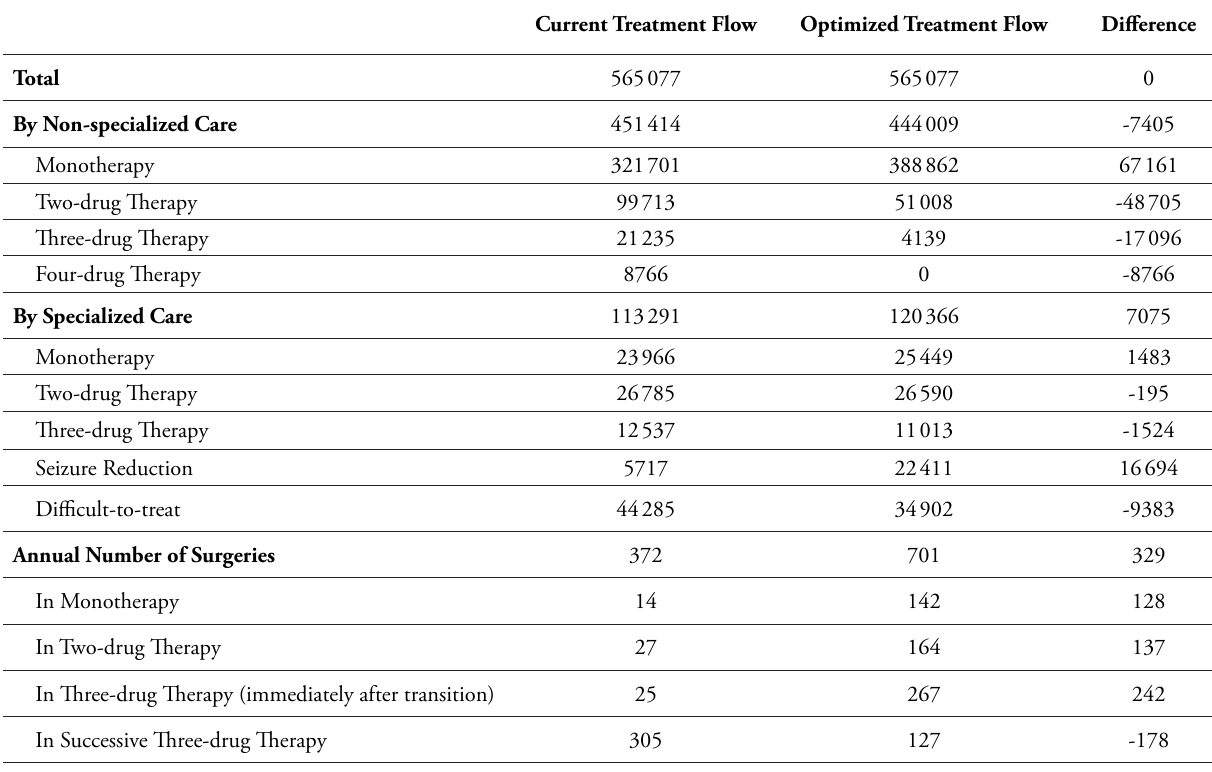
Table 5: Results of Base-case Analysis for Patient Distribution